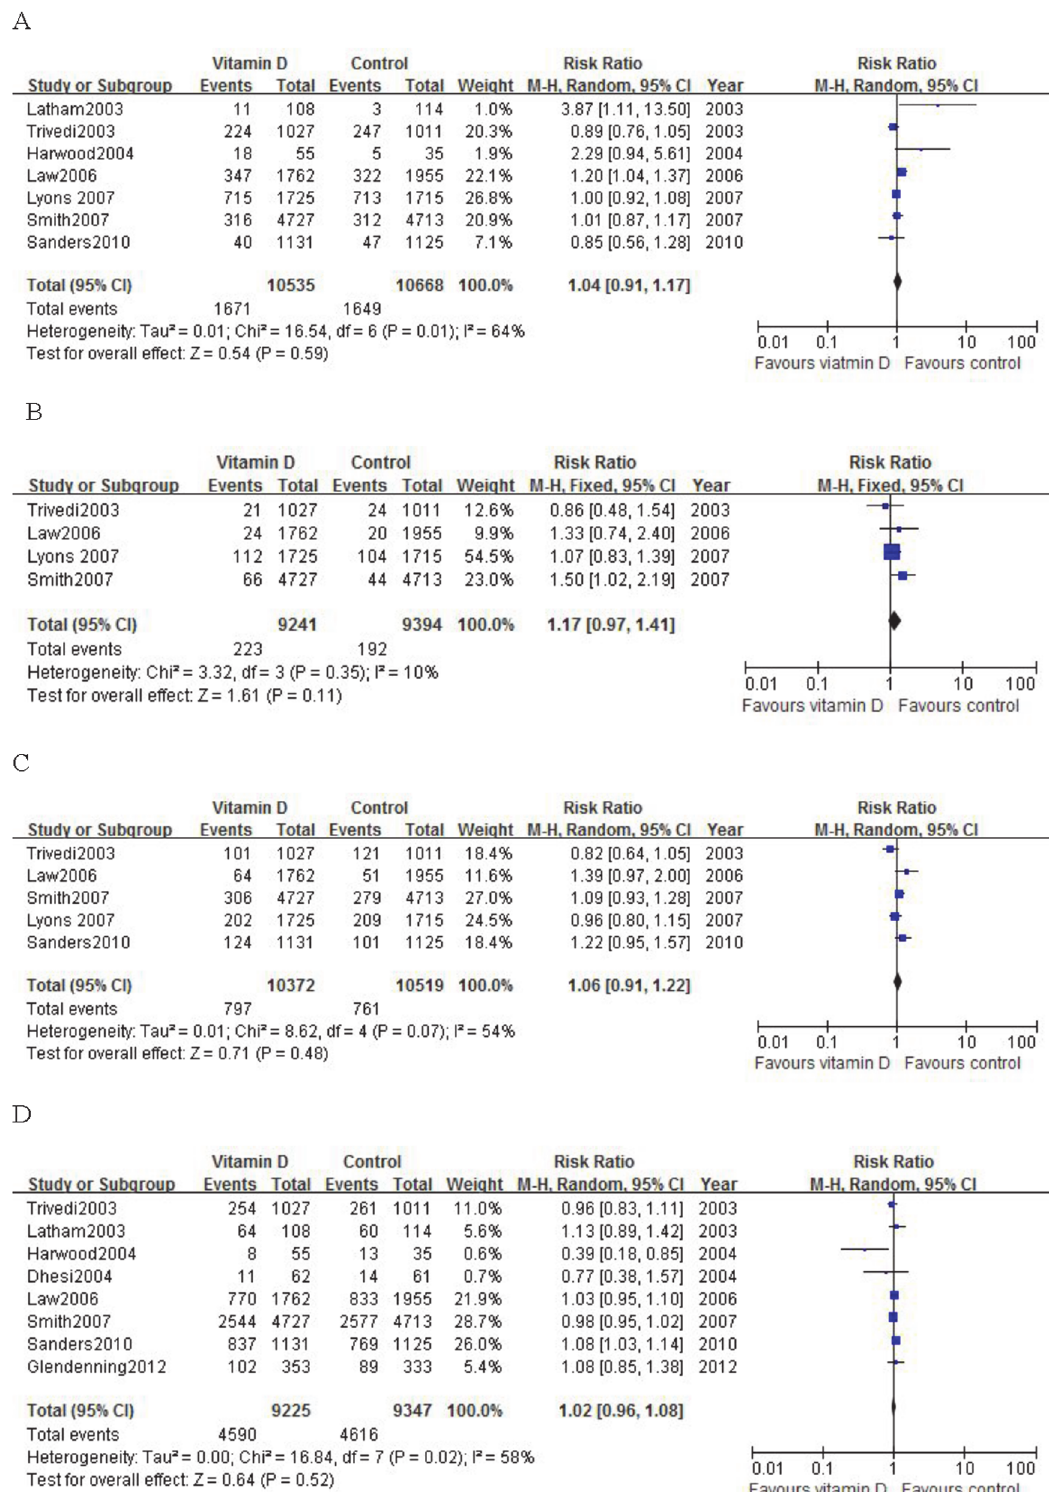
Figure 2. Meta analysis of overall mortality (A), hip fracture (B), non-vertebral fracture (C), fall (D) in participants treatment with high dose, intermittent vitamin D compare with control.